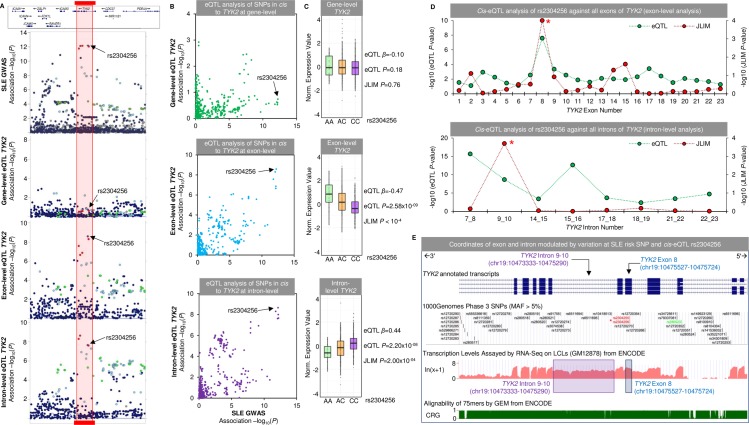
Isolation of potential causal molecular mechanism in TYK2 by SLE cis-eQTL rs2304256.(A) SLE GWAS association plot and cis-eQTL association plot around the 19p13.2 susceptibility locus tagged by rs2304256. The top panel shows the association plot with SLE that spans the gene body and 3′ region of TYK2 (Tyrosine Kinase 2). The haplotype block composed of highly correlated SNPs is highlighted in the red block. The second panel shows the cis-eQTL association plot at gene-level of all proximal SNPs to TYK2 (no significant association with rs2304256 is detected). The third panel shows the same regional association but at exon-level for the most associated exon of TYK2 with rs2304256 –the bottom panel is at intron-level for TYK2 (both are highly associated). (B) Correlation of SLE GWAS P-value and cis-eQTL association P-value for all SNPs in cis to TYK2. We show at gene-level the most associated SLE SNPs are not cis-eQTLs (top panel). The middle and bottom panels show the same correlation at exon-level and intron-level and reveal the most associated SNPs to SLE are also the most associated cis-eQTLs to TYK2. (C) The direction of effect of cis-eQTL rs2304256 with TYK2 at gene-level (top), exon-level (middle), and intron-level (bottom panel). The risk allele is rs2304256 [C]. (D) The top panel shows cis-eQTL association and JLIM P-values for all exons of TYK2 against rs2304256. Exon 8 (marked by an asterisk) is defined as having a causal association with rs2304256. The bottom panel shows the intron-level cis-eQTL of TYK2 against rs2304256. Note many introns are cis-eQTLs but are not causal with rs2304256. Exons and introns are numbered consecutively from start to end of gene if they are expressed (note some are not and therefore not included). (E) The genomic location of the single exon and single intron of TYK2 that are modulated by rs2304256 are highlighted (rs2304256 is marked by an asterisk in red). The bottom two panels show the transcription levels assayed by RNA-Seq on LCLs assayed by ENCODE. Note intron 9–10 of TYK2 is clearly expressed. The alignability of 75-mers by GEM is also shown to show the mapability of reads around rs2304256.